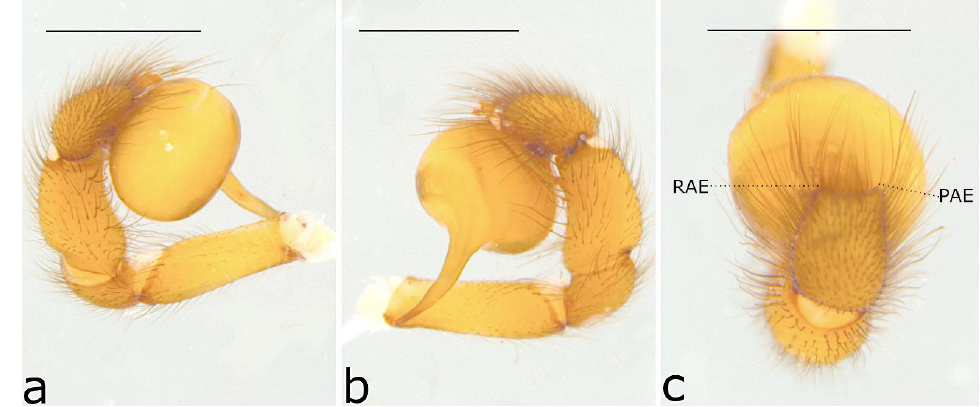
Figure 51. Ariadna rutila sp. nov. ♂ holotype (SAMA NN30477) from Muckera (SA): ( a ) left pedipalp, prolateral view; ( b ) same, retrolateral view and ( c ) same, cymbium. Scale bar = 1 mm.